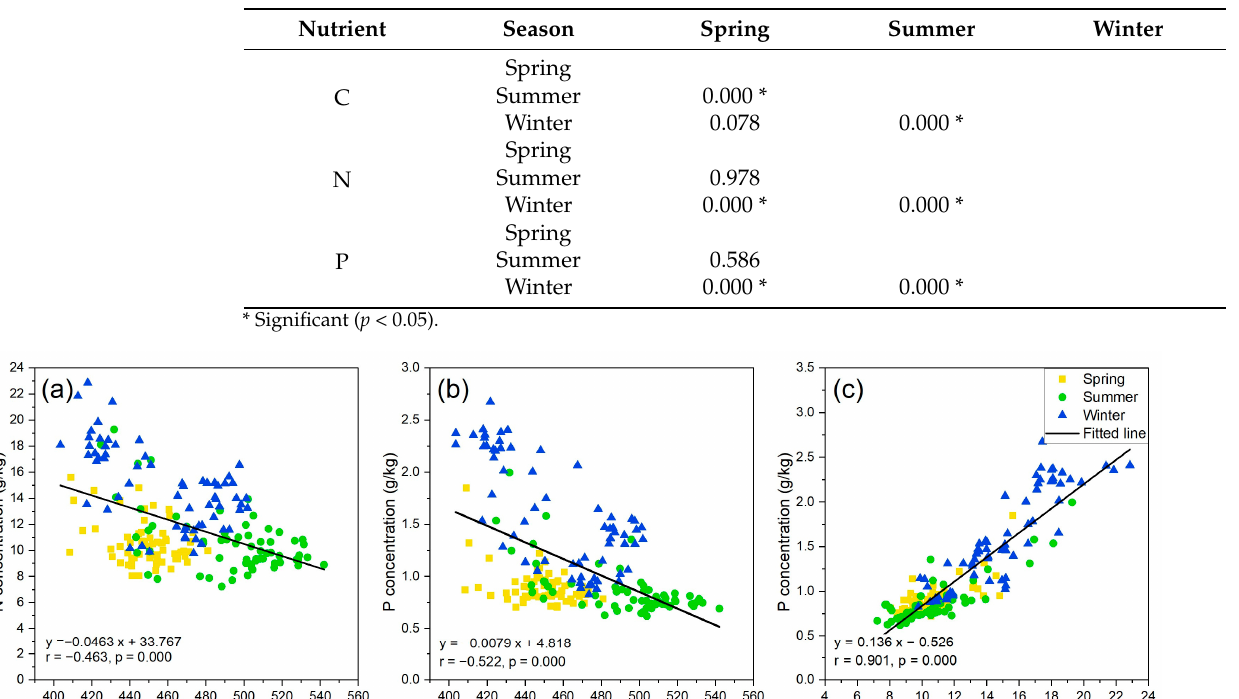
Table 7. ANOVA of leaf nutrients between seasons.